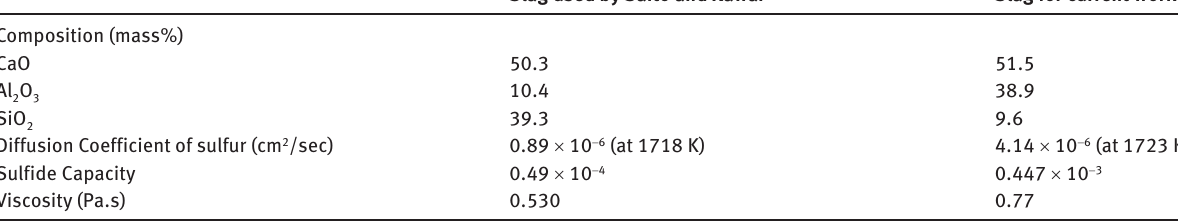
Table III: Comparison between the slags used by SaitÔ and Kawai [15] and the current